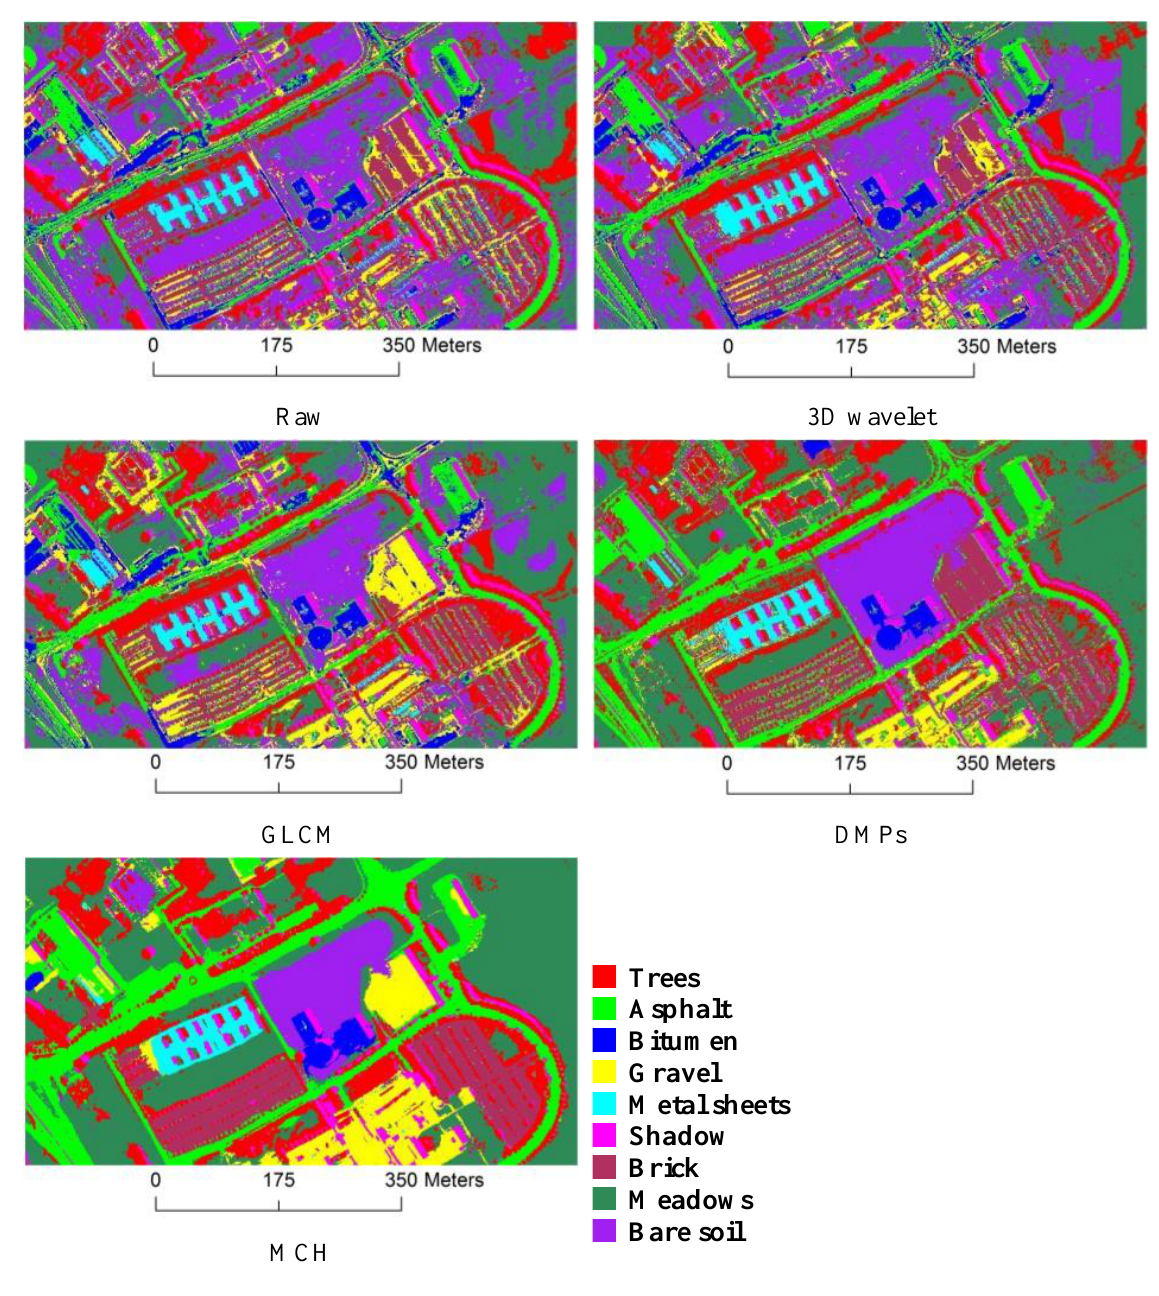
Figure 11. An overview of the classification maps for the Pavia University